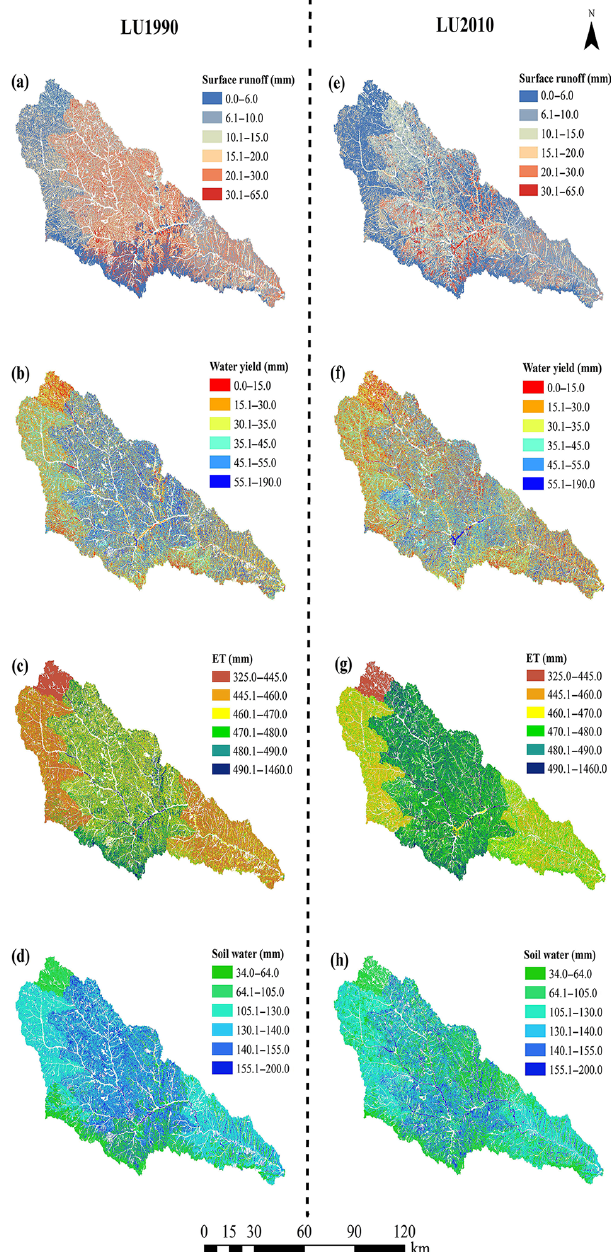
Figure 7. Simulated spatial distribution of surface runoff, water yield, ET, and soil water under land use change between 1990 (a– d) and 2010 (e–h)